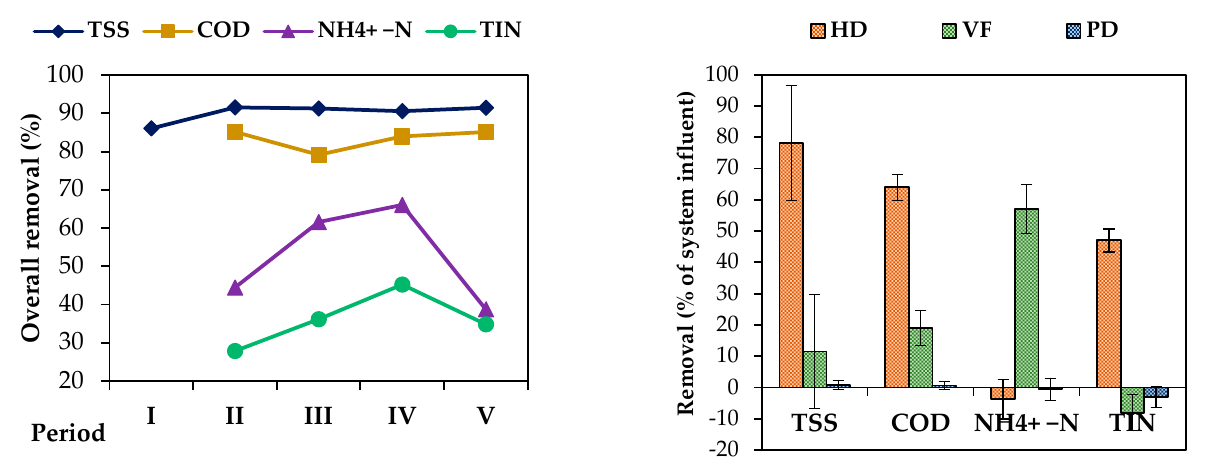
Figure 4. Evolution of percentage removal of TSS, COD, NH 4+ -N, and TIN in the overall system and contribution of each unit. Acronyms: TSS = total suspended solids; COD = chemical oxygen demand; NH 4+ -N = ammonium; TIN = total inorganic nitrogen; HD = hybrid digester; VF = vertical flow constructed wetland; PD = photodegradation lamp.